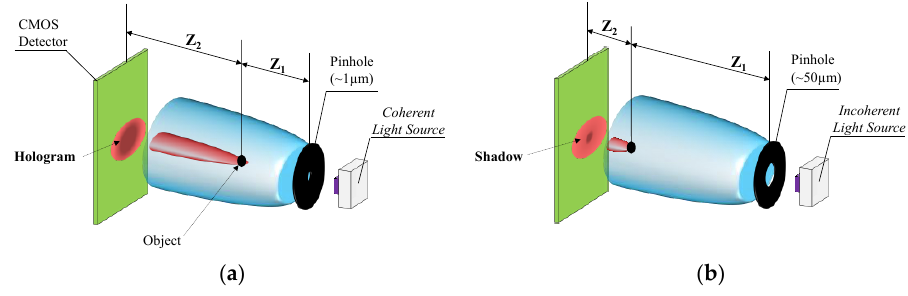
Figure 3. Coherent ( a ) and Incoherent ( b ) lens-less approaches.